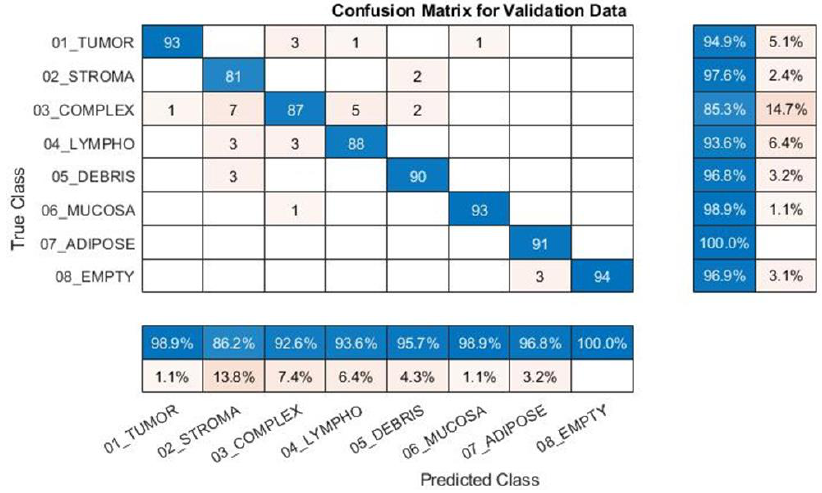
Figure 11. Experiment II: accuracy of eight classes (Kather-texture-2016-image-5000). By the same token, based on the experimental results, it can be seen that, when revis- ing the parameters, ResNet50 was found to have achieved the highest accuracy rate at 15 epoch shown in Figure 12a, and 32 mini-batch size for nine classes of CRC images, as shown in Figure 12b. Furthermore, the same parameters of the ResNet50 neural network used for eight types of CRC images achieved a ratio of 94.86% accuracy, as shown in Fig- ure 13a,b. Further extensive experiments have been conducted to verify the efficacy of different variants of the ResNet architecture, such as ResNet18, ResNet50 and ResNet101 [26]. It is also worth noting that an accuracy rate of 99.69% can be achieved using 177 layers of a neural network (ResNet50), which is better than the 98.61% using 71 layers of ResNet18 and the 99.31% using 347 layers of ResNet101. Furthermore, an accuracy rate of 94.86% can be achieved using 177 layers and the same parameters of a ResNet50 neural network for eight classes of CRC images, which is better than the 92.86% using 71 layers of ResNet18 and the 94.16%, using 347 layers of ResNet101. The differences between Res- Net18, ResNet50 and ResNet101 are highlighted in Figure 14. It can be seen from the pre- vious experiments that the best classification accuracy rate can achieved by revising the parameters and using ResNet50.